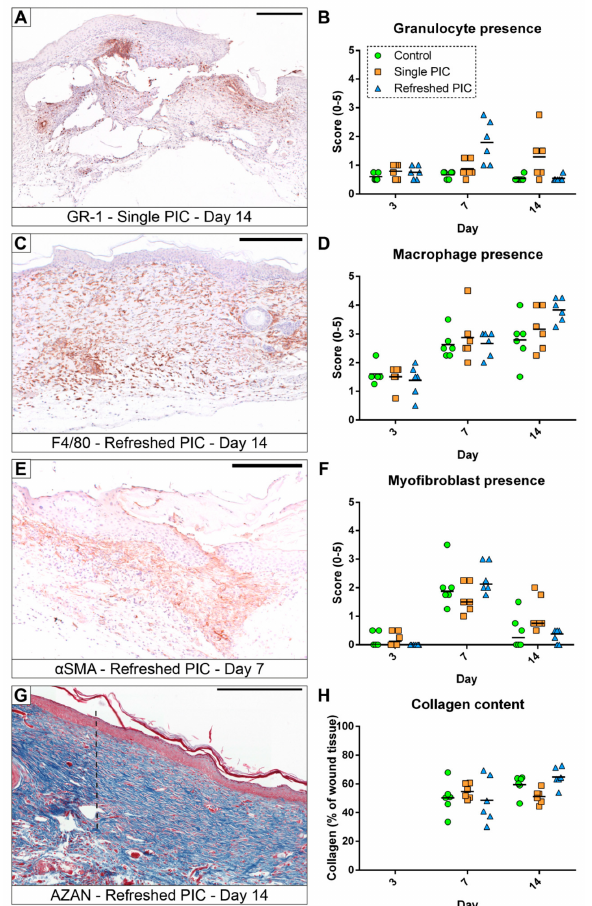
Figure 5. Representative histologically stained sections and the quantitative results of the associated analyses. ( A , B ) Granulocytes represented only a small percentage of the wound tissue but are increased in several specimens. ( C , D ) Macrophages were present in each phase of the wound repair, the influx was observed from nearby healthy tissue, and they were a dominant cell type, especially at later time points. ( E , F ) The differentiation of fibroblasts into α SMA-positive myofibroblasts occurred mainly in the proliferation phase (day 7, ( E )). ( G , H ) The percentage of blue-positive collagenous tissue was quantified digitally; in the depicted section ( G ), the transition from the dark-blue highly organised collagen in healthy tissue into the lighter-blue less organised collagen in the wound repair tissue is very apparent (indicated by the dashed black line). The scale bars indicate 250 µ m, and the horizontal lines represent the means in all graphs except the myofibroblast presence, where the median is